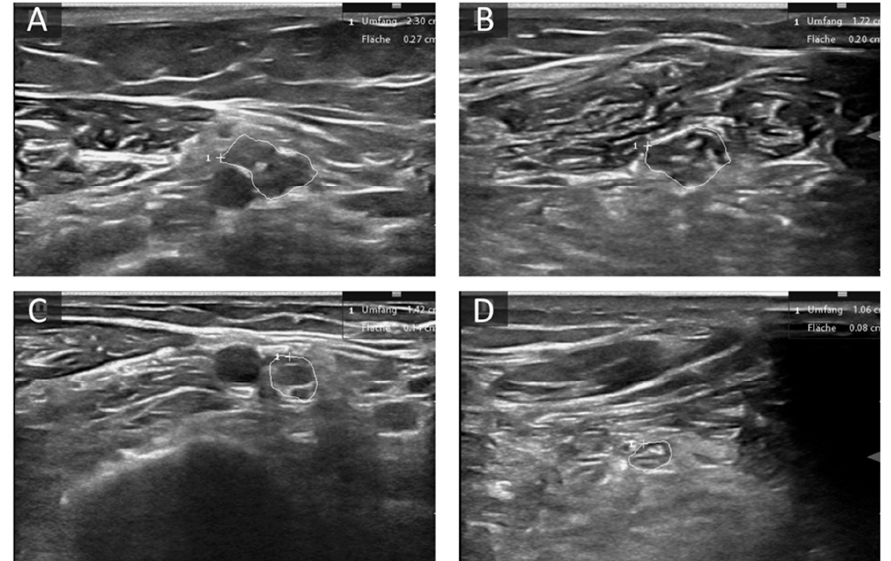
Figure 2. Examples of altered nerve morphology in hereditary neuropathies. ( A,B ) Cross-sectional view of the median nerve at the upper arm ( A ) and forearm ( B ) of a patient with Charcot Marie Tooth (CMT) 1A. CSA is enlarged (27 mm² upper arm, 20 mm² forearm) and the fascicles are hypoechoic. ( C,D ) Cross-sectional view of the median nerve at the upper arm ( C ) and forearm ( D ) of a patient with transthyretin related amyloidosis (ATTR). CSA is mildly enlarged at the upper arm (14 mm²) and normal at forearm level (8 mm²). The area enclosed by circles depicts CSA of the described nerve section, “+” shows curser position, “1” the count of measured areae.